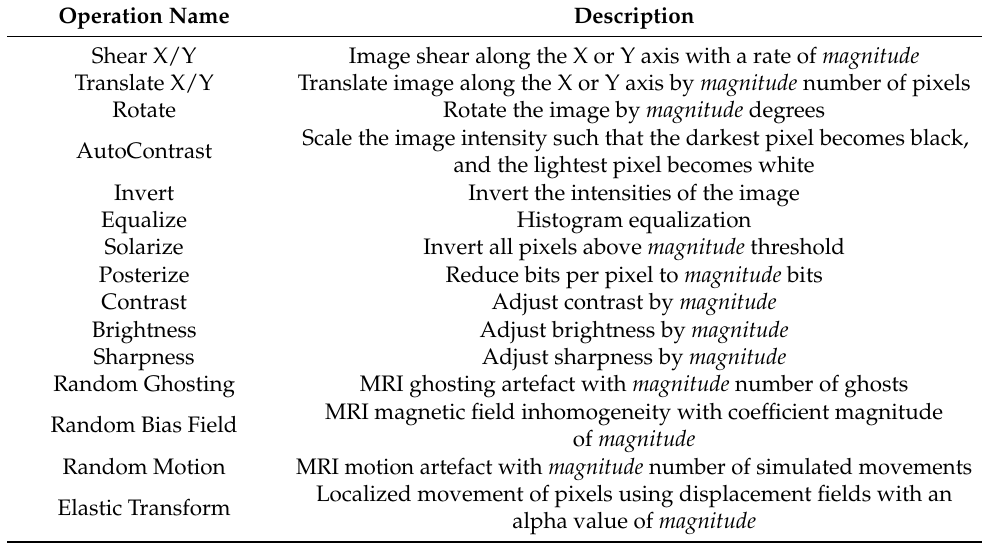
Table 1. Full list of all the transformation operations used in this